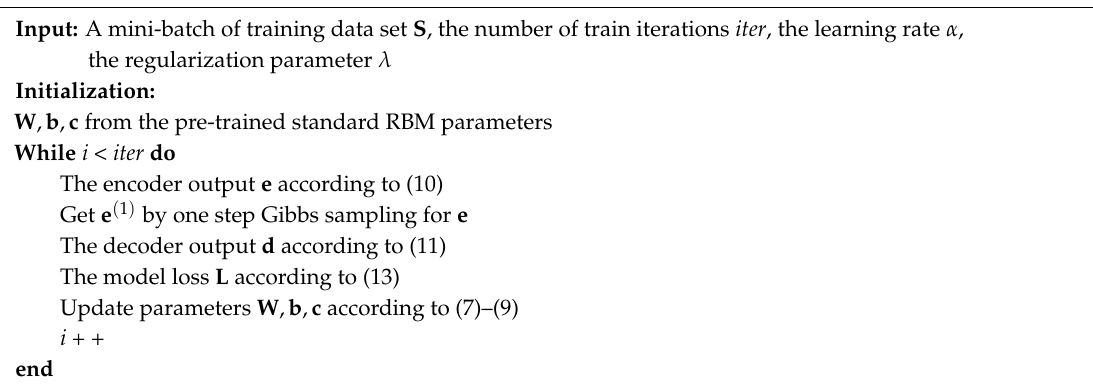
Algorithm 2: Retraining of Stacked